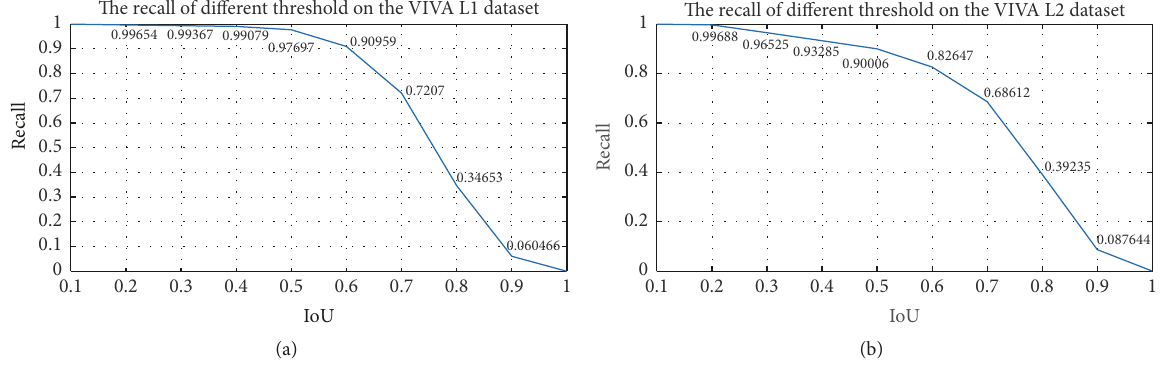
Figure 11: Recall of the Edgeboxes algorithm on the VIVA hand detection dataset: (a) L1; (b) L2.